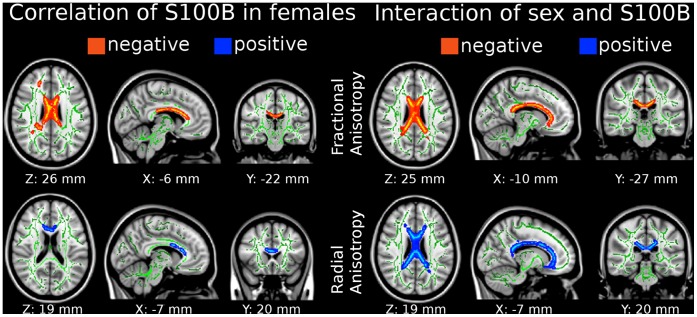
Diffusion tensor imaging parameters correlate with serum S100B mainly in the corpus callosum, anterior forceps, and the right superior longitudinal fasciculus of the female brain (left) in comparison with male brains (right).Clusters are corrected for multiple comparisons (p<0.05, threshold-free cluster enhancement), positions are reported in MNI-coordinates. There was no significant correlation of S100B in male brains alone using multiple comparison correction and very little using uncorrected thresholds (not shown). Radiological convention (left side of the brain is presented on the right).